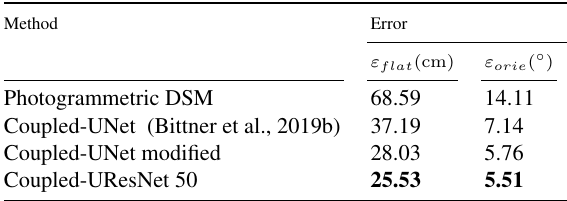
Table 2. Quantitative results for flatness and orientation metrics evaluated over selected test area of Berlin